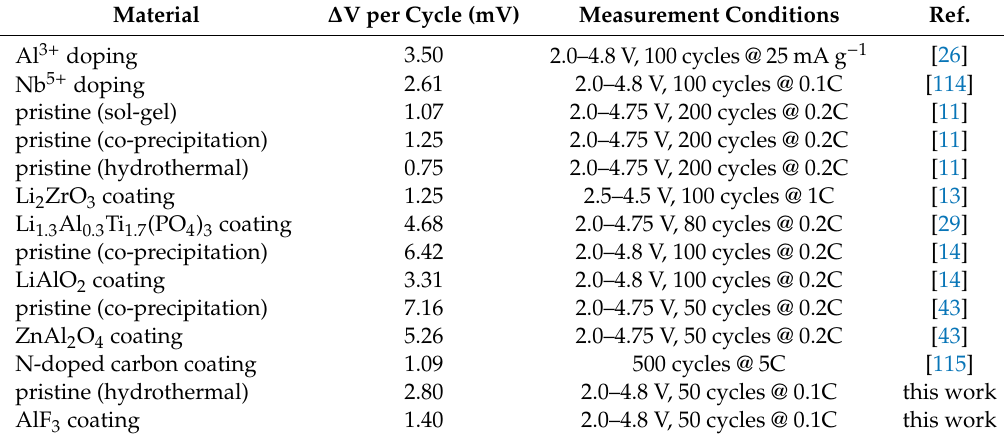
Table 5. Voltage decay rate for di ff erent Li-rich Li 1.2 Ni 0.2 Mn 0.6 O 2 cathode